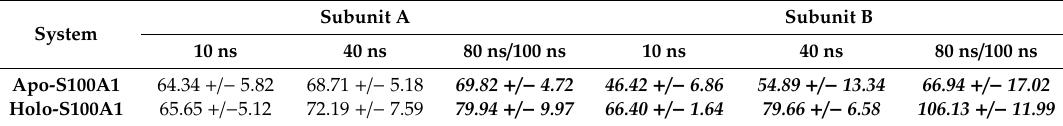
Table 2. Angle estimations between H3-EF site-H4 topology at various simulation time intervals for each subunit. Angles are calculated based on the yellow line in Figure 3. More than 10 ◦ angle di ff erences in apo and holo states are depicted in bold and italic